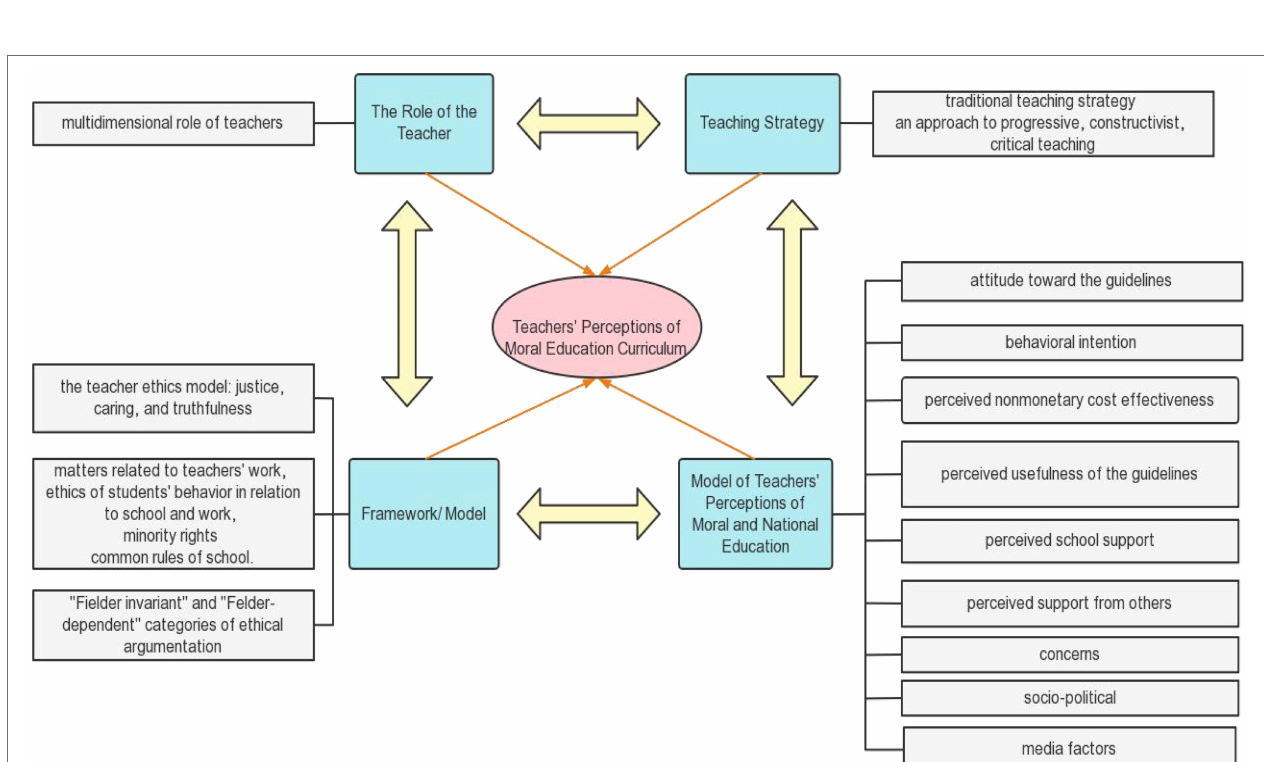
FIGURE 9 | A conceptual framework for teachers’ perceptions of moral education